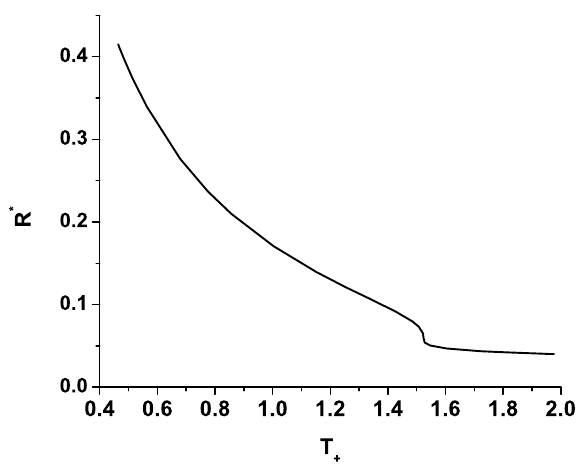
Figure 4 . The relation between the bubble radius and its temperature. The bubble temperature gets lower as the radius is increasing. We set M + = 0 . 02 , Λ + = 3 , Λ − = 0 . 03 and G = 1 , and change the black hole rest mass M − .